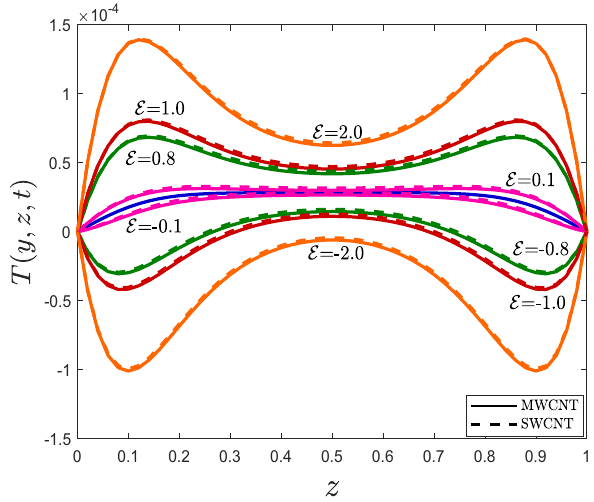
Figure 9. One-dimensional temperature profile for different values of E